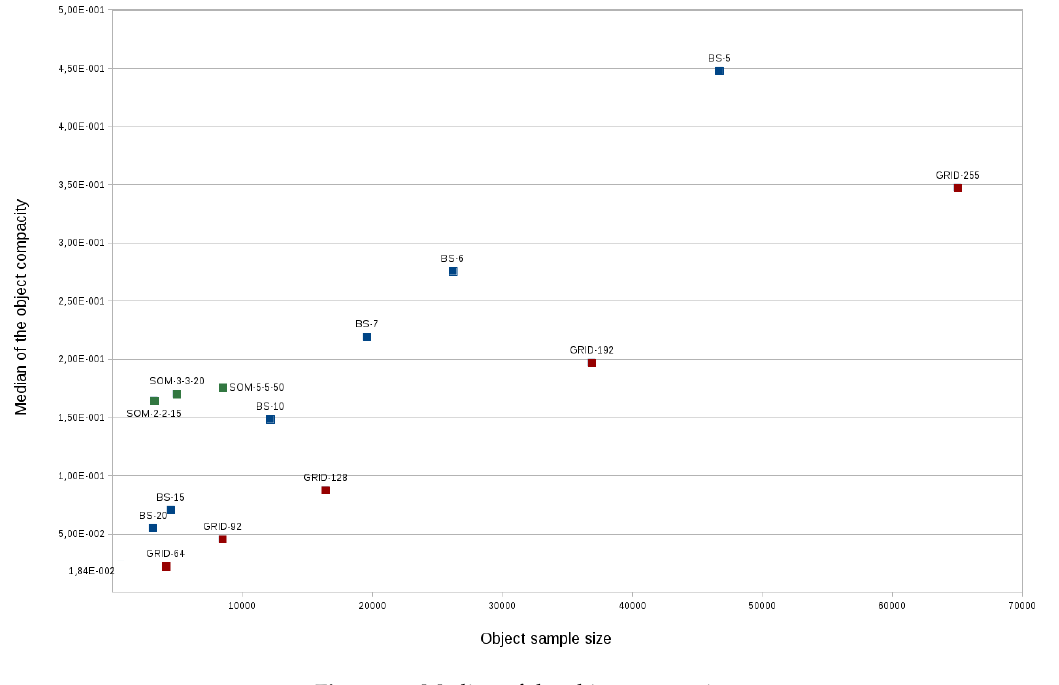
Figure 11. Median of the object compacity.